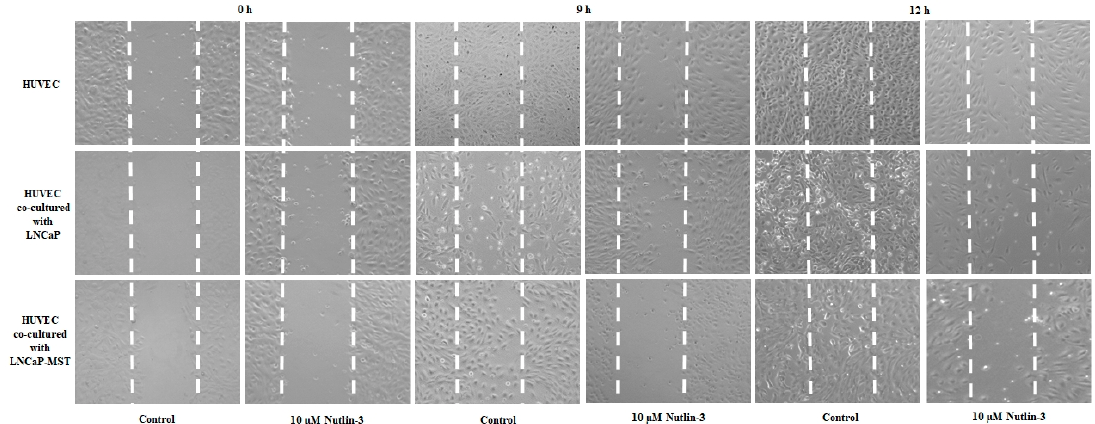
Figure 6. Effects of co-culturing MDM2 expressing cells with HUVECs on the migration of HUVECs before and after Nutlin-3 (10 µM) treatment was assessed. Scratch assay was carried out to assess cell migration ability of HUVECs. After making the scratch lines, images were captured at 0, 9 and 12 h.